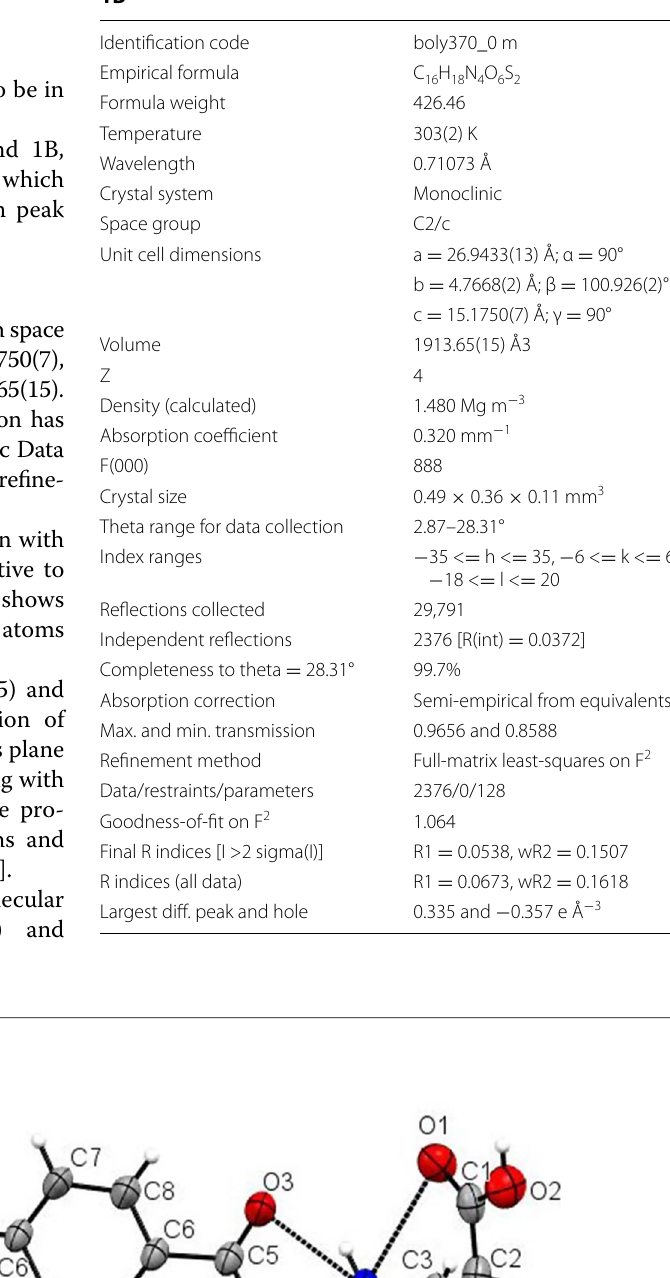
Table 1 Crystal data and structure refinement for isomer